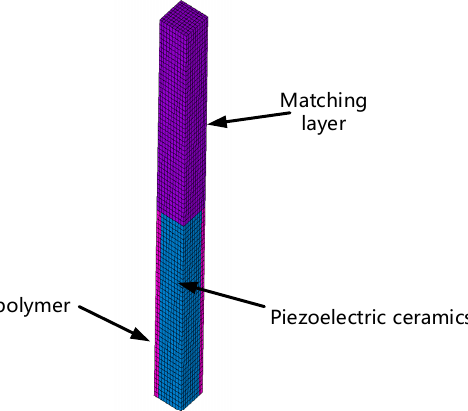
Figure 4. 1–3 Finite Element Model of Piezoelectric Composites .